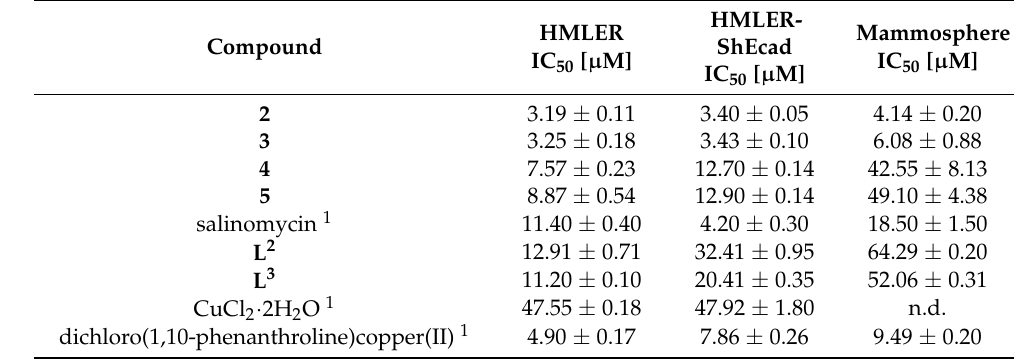
Table 1. IC 50 values of the copper(II) complexes 2 – 5 , the naphthol Schiff base ligands L 2 and L 3 , salinomycin, CuCl 2 · 2H 2 O, and dichloro(1,10-phenanthroline)copper(II) against HMLER and HMLER-shEcad cells and HMLER-shEcad mammospheres determined after 72 h or 120 h incubation (mean of three independent experiments ±